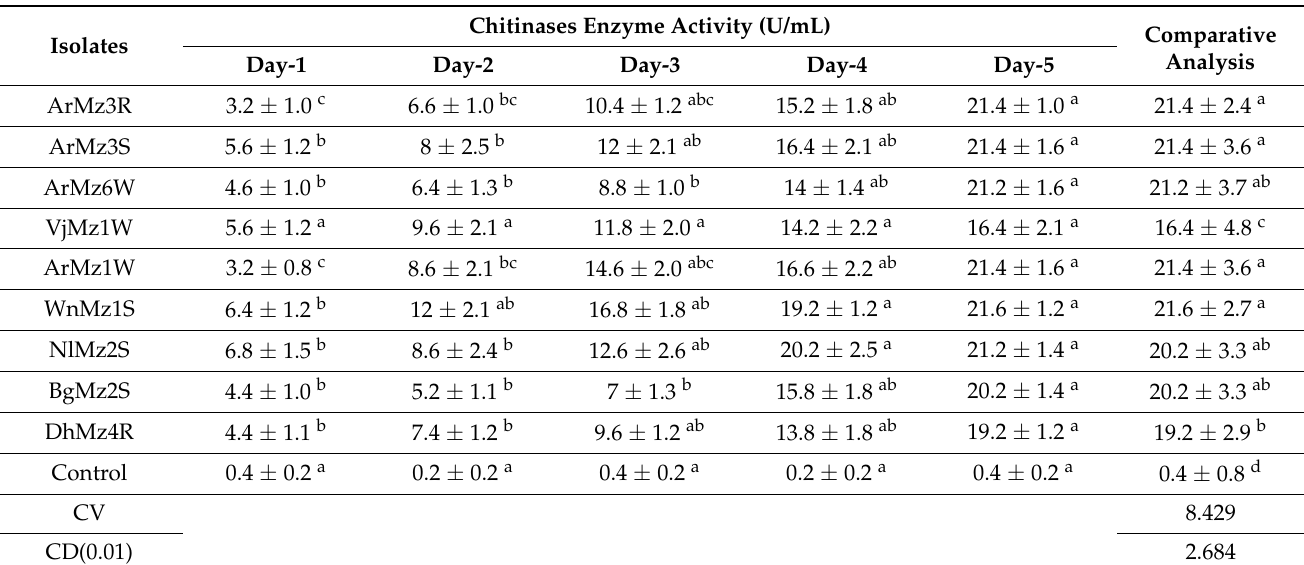
Table 4. Activities of chitinase (U/mL) (Mean ± SE) in the liquid culture media of the ento- mopathogenic fungi in the presence of H. puera cuticle. Chitinases Enzyme Activity (U/mL) Isolates